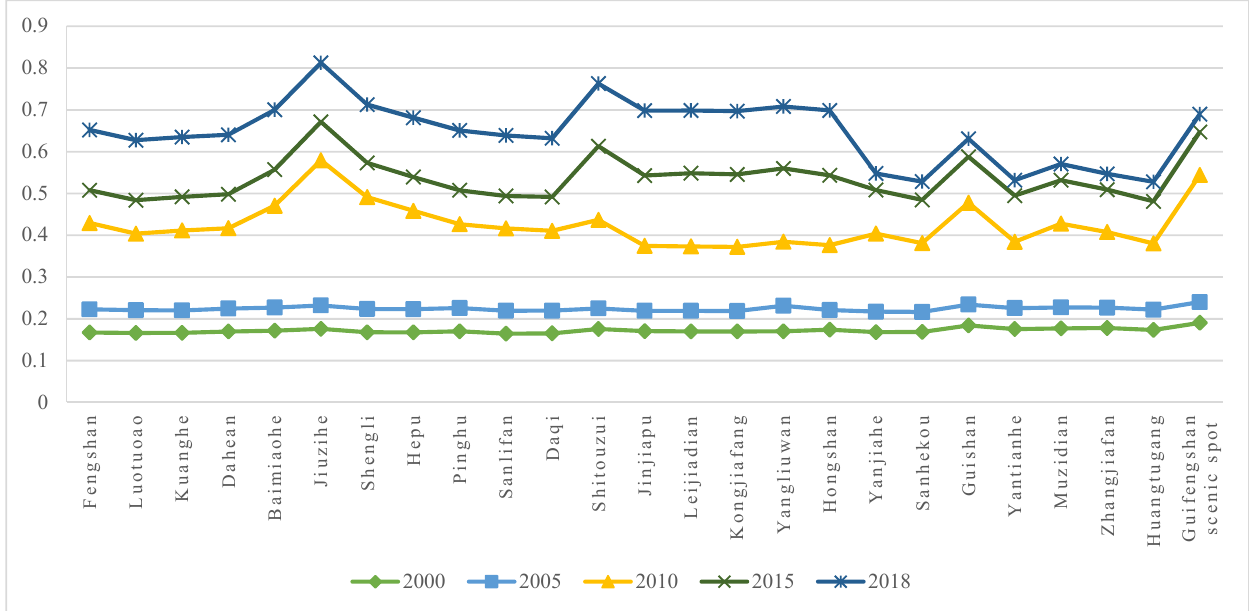
Figure 5. Distribution of TESI in Huanggang Dabieshan UGGp from 2000 to 2018.